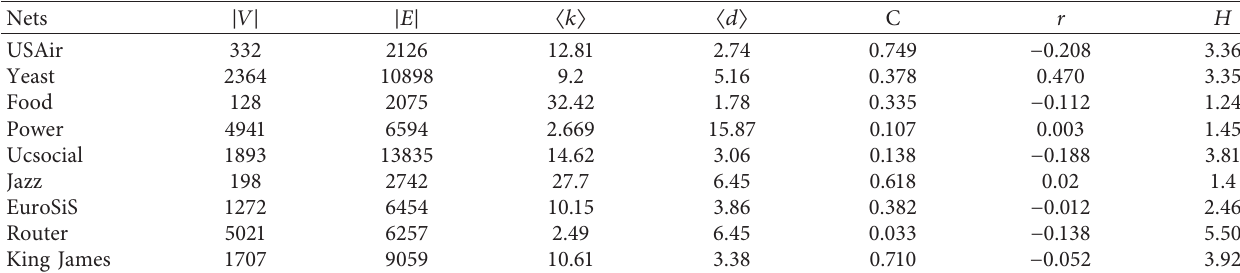
Table 1: The basic statistical features of the 9 benchmark